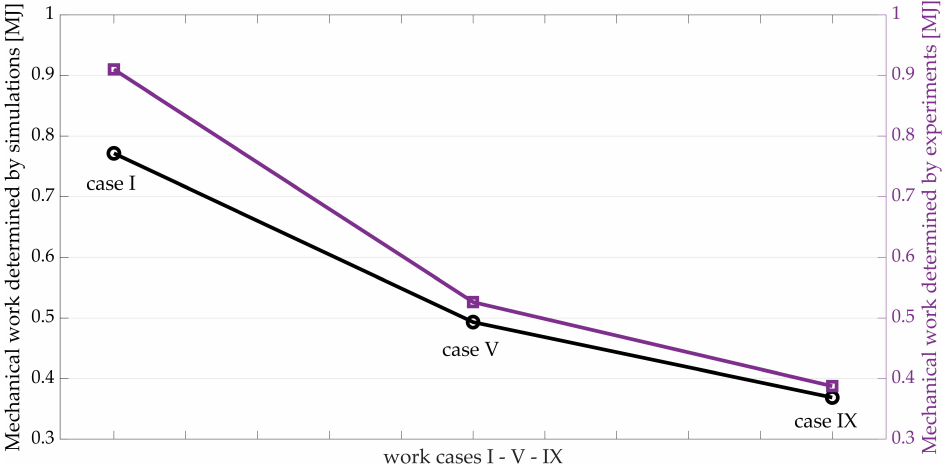
Figure 18. Graphical comparison between experimental and simulated data for the mechanical